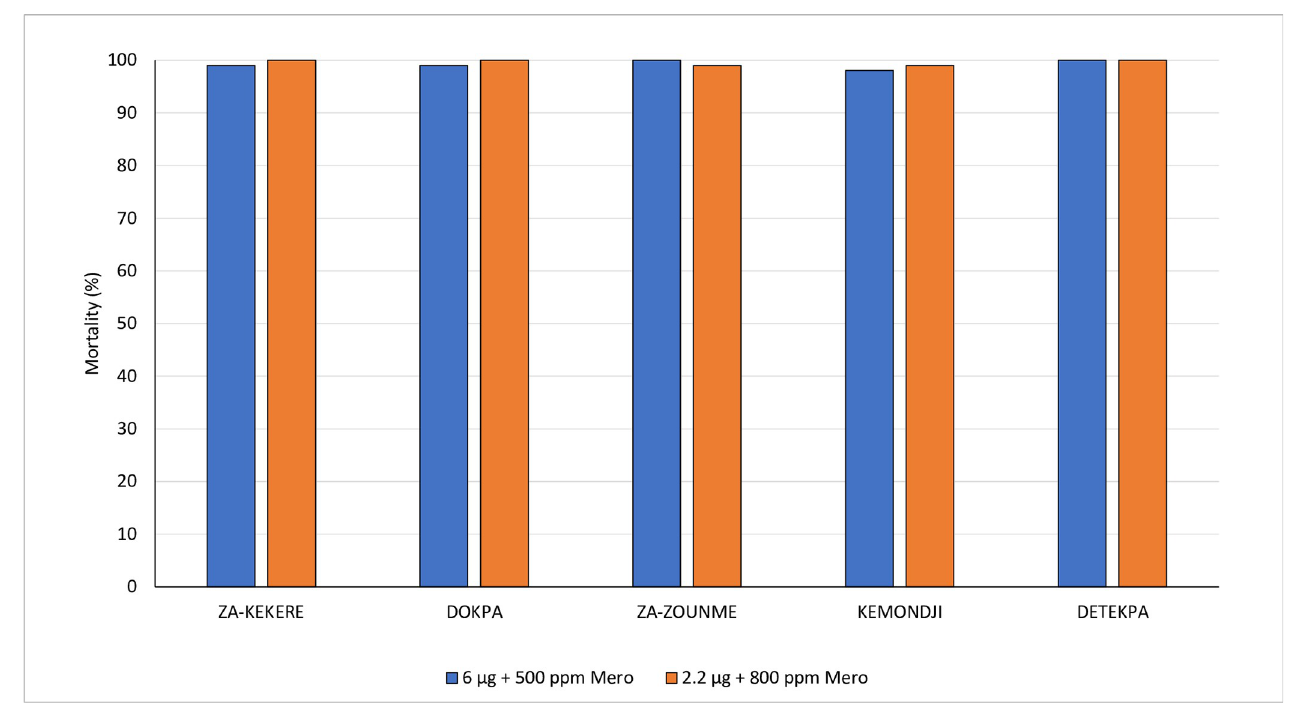
Fig 5. Mortality (72h) of wild An . gambiae s.l. from southern Benin in bottle bioassays with estimated discriminating concentrations of broflanilide.